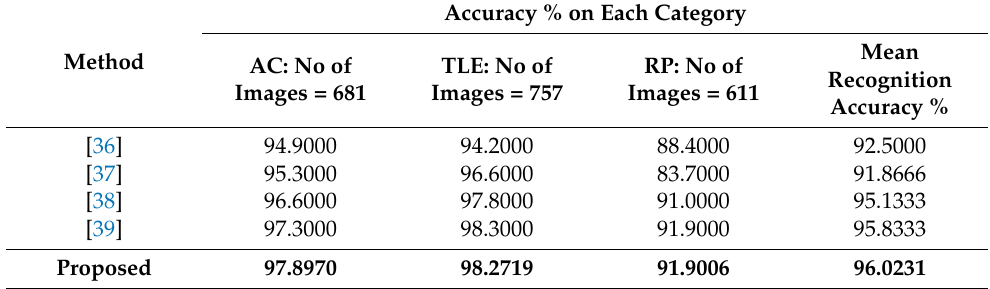
Table 4. Comparison of the AOLP dataset.